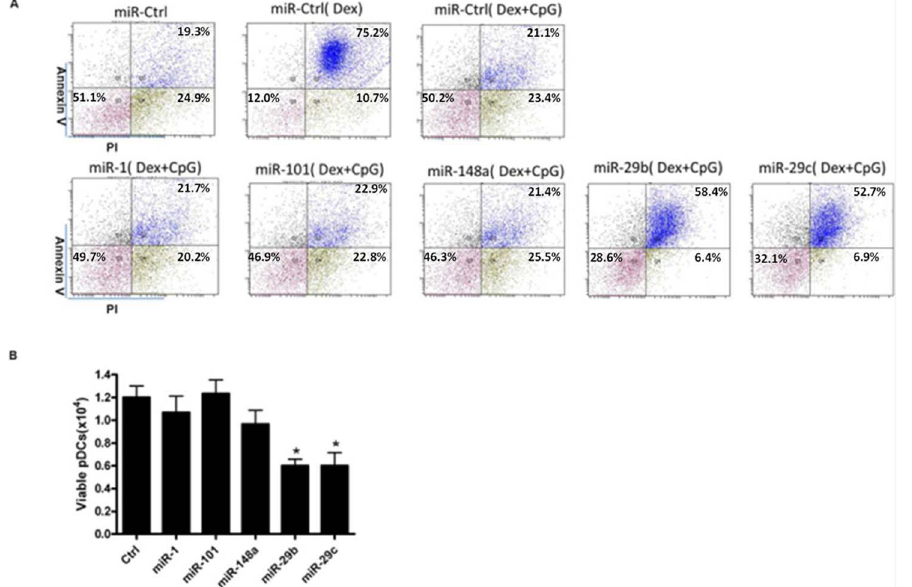
Figure 5. miR-29b and miR-29c are involved in TLR-inhibited Dex-induced pDC apoptosis. (A, B) Primary pDCs were transfected with control (Ctrl), miR-1, miR-101, miR-148, miR-29b, or miR-29c mimics. Then, cells were stimulated with Dex alone or the combination of Dex and CpG, and pDC apoptosis was analyzed 16 hours post-stimulation. The data are representative of at least 3 independent experiments, each using a different pDC preparation. Data are expressed as the mean 6 SD and were analyzed with a 2-tailed Student’s t test. *P , 0.05.